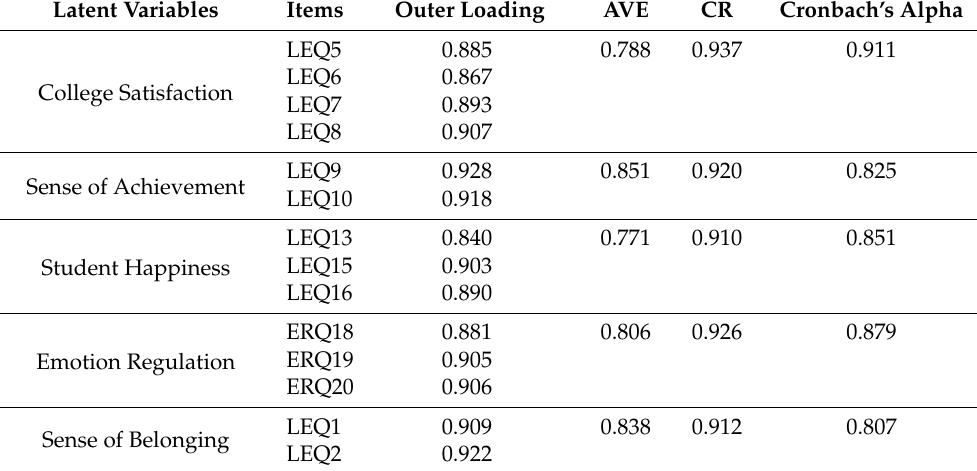
Table 1. Summary of the measurement